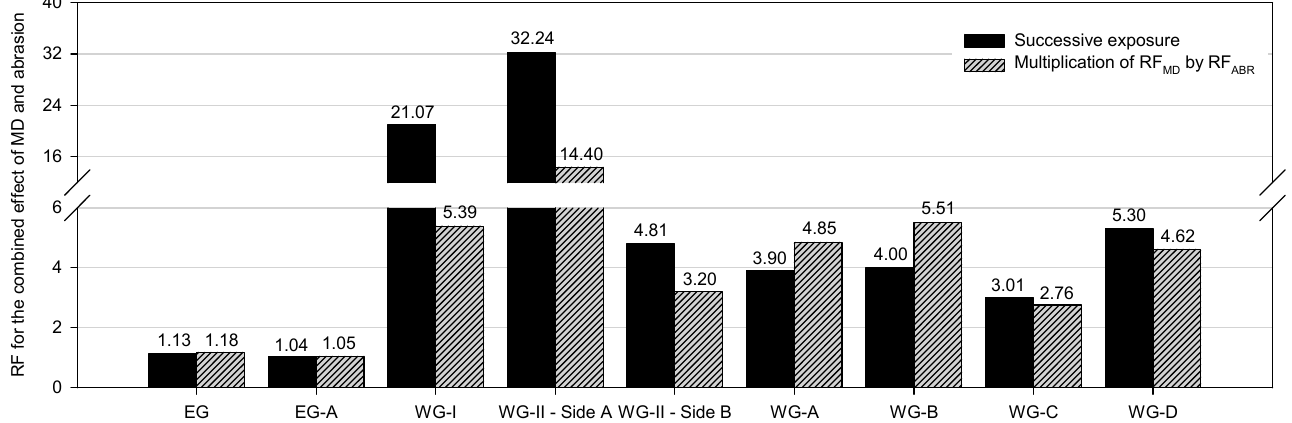
Figure 9. Comparison between reduction factors (RFs) obtained in this work and in other studies [13,24,25] for the combined effect of MD and abrasion on geogrids. (EG-A—polypropylene extruded biaxial geogrid with tensile strength of 46.6 kN · m − 1 ; WG-A—polyester woven geogrid with tensile strength of 44.4 kN · m − 1 ; WG-B—polyester woven geogrid with tensile strength of 47.5 kN · m − 1 ; WG-C—polypropylene woven geogrid with tensile strength of 44.4 kN · m − 1 ; WG-D—polyester woven geogrid with tensile strength of 39.8 kN · m − 1 ).